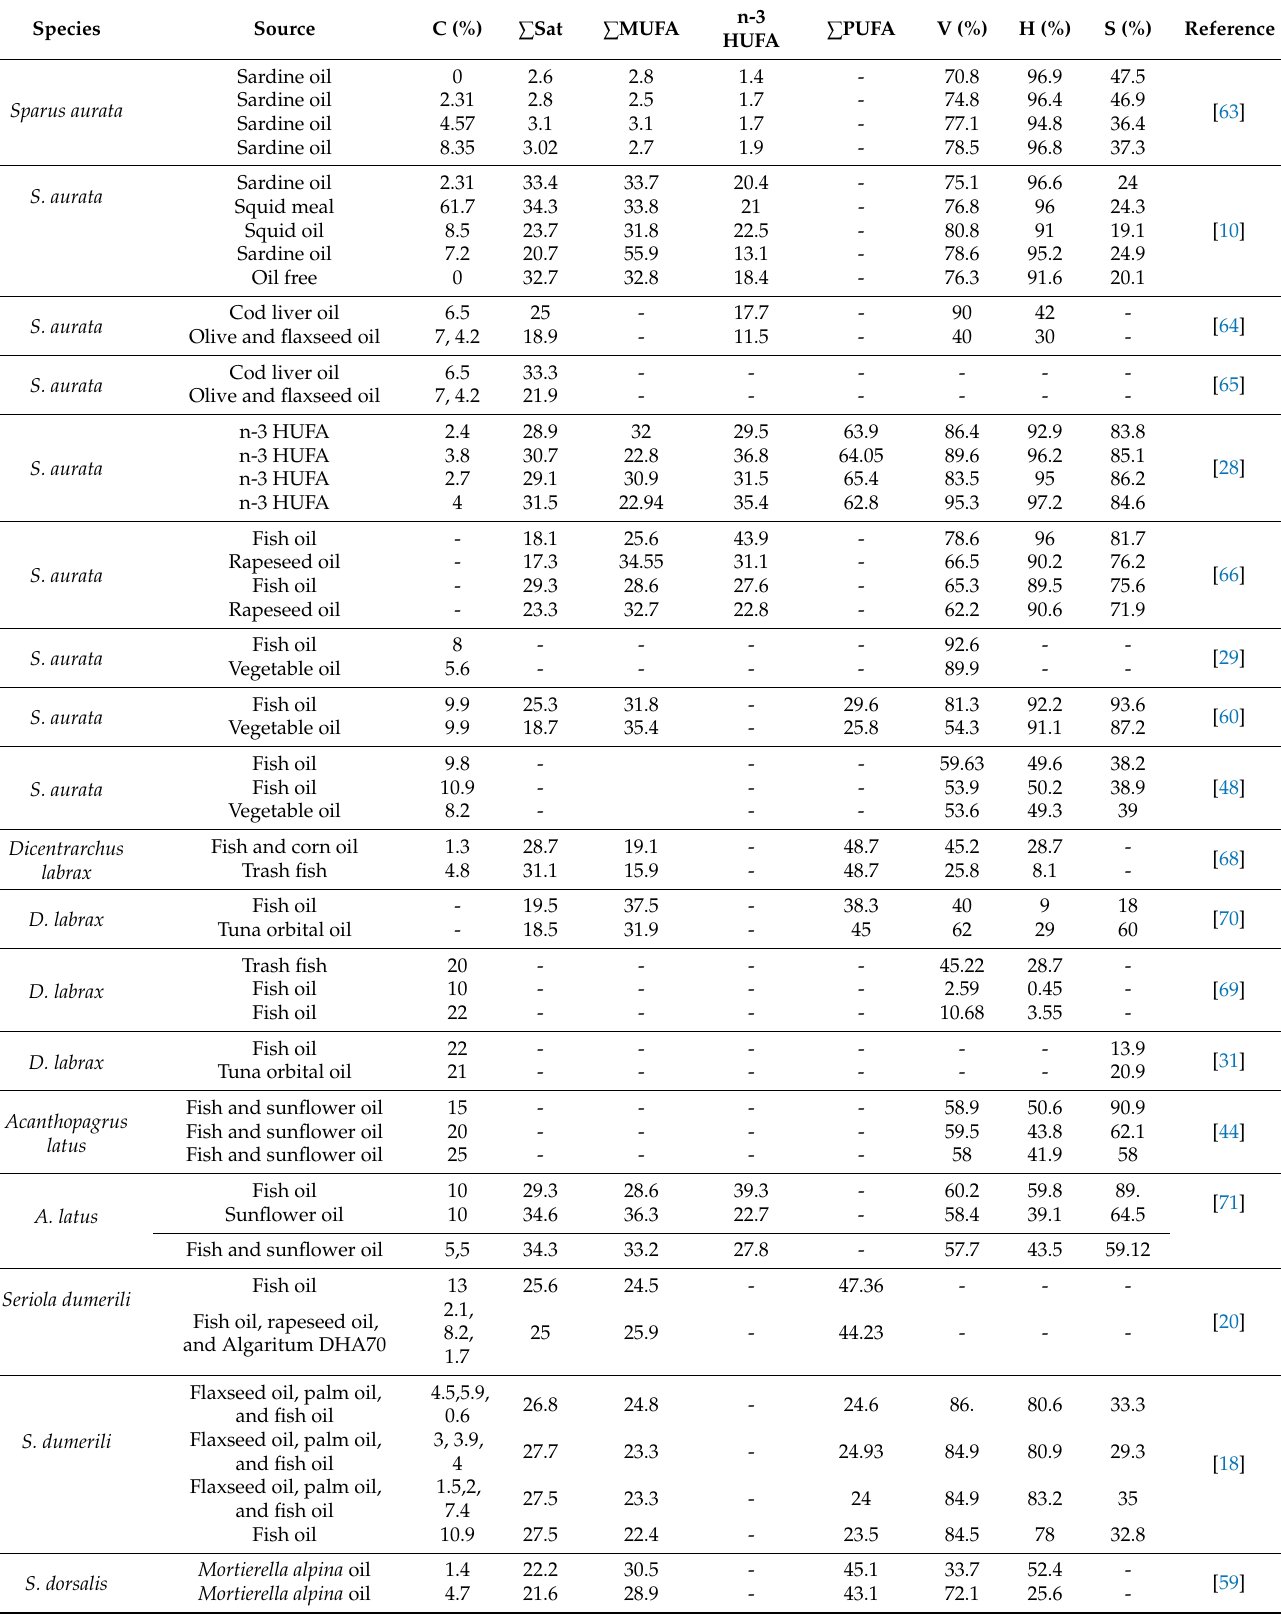
Table 7. Egg fatty acid composition and reproductive performance with use of different lipid